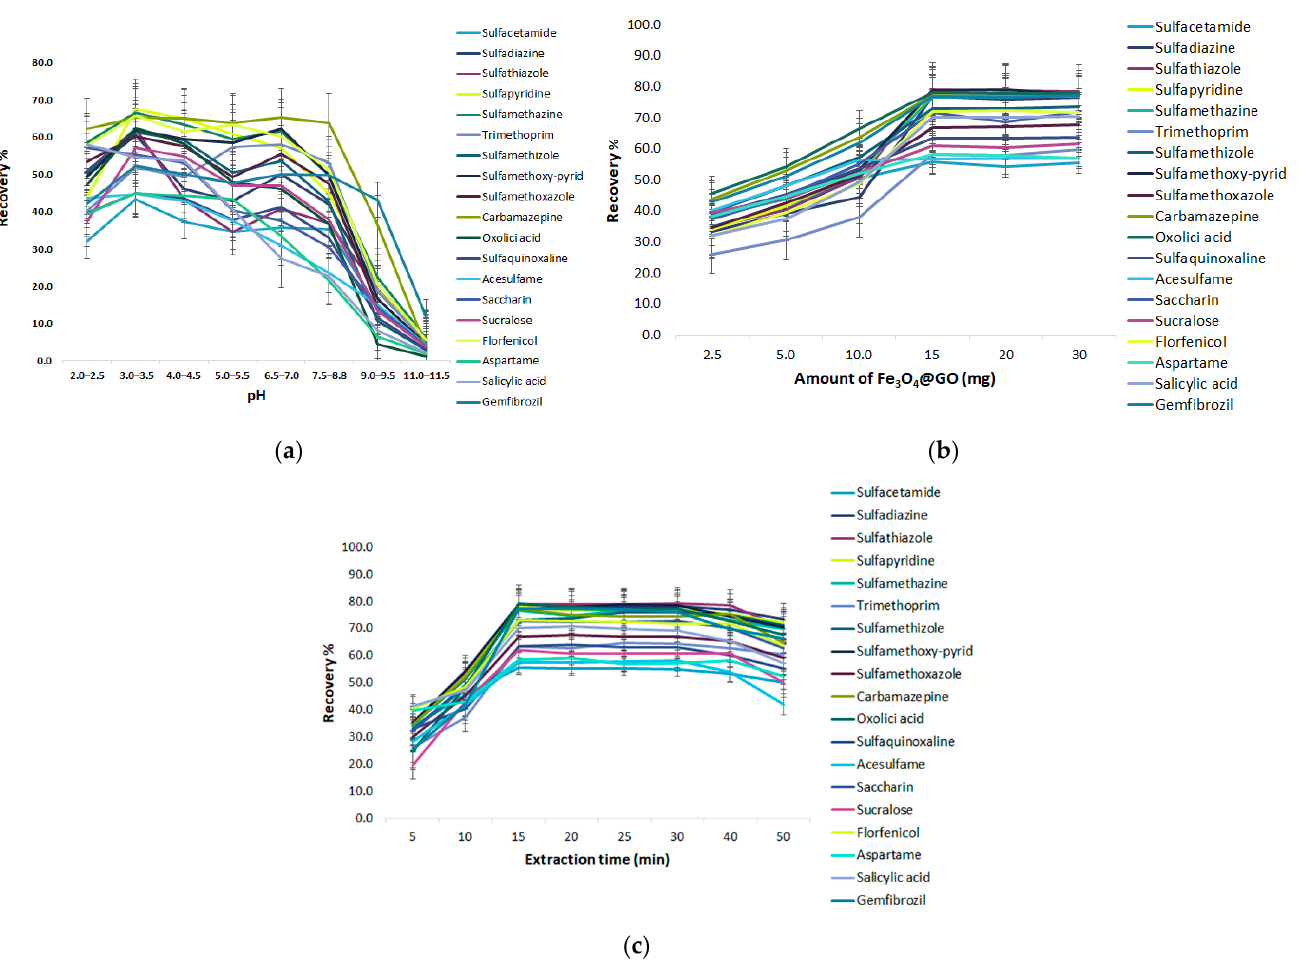
Figure 5. Effect of the extraction parameters of MSPE@GO ( a ) pH, ( b ) amount of GO@Fe 3 O 4 , ( c ) extraction time.